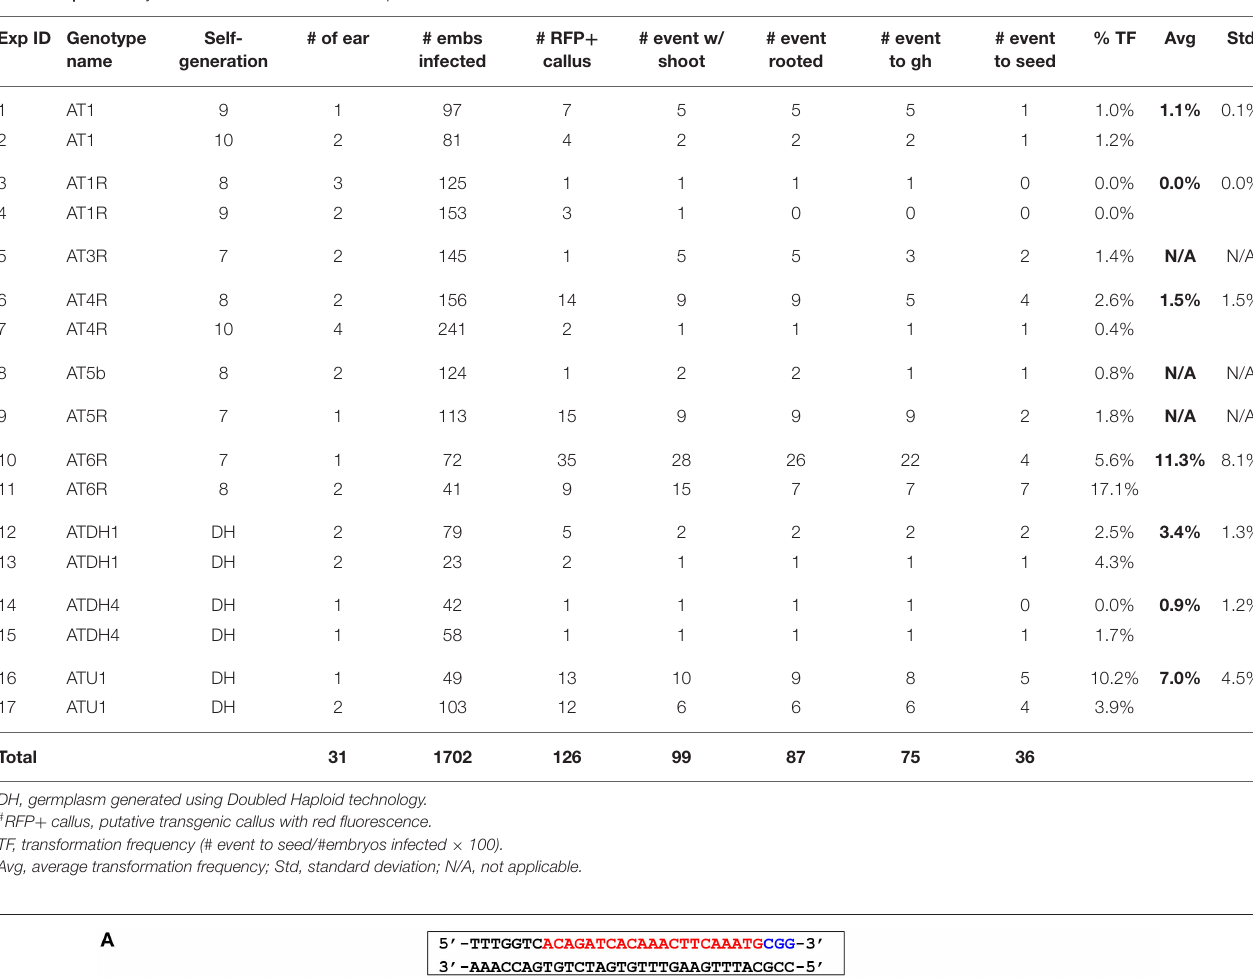
TABLE 1 | Summary of FFMM-AT transformation experiments.